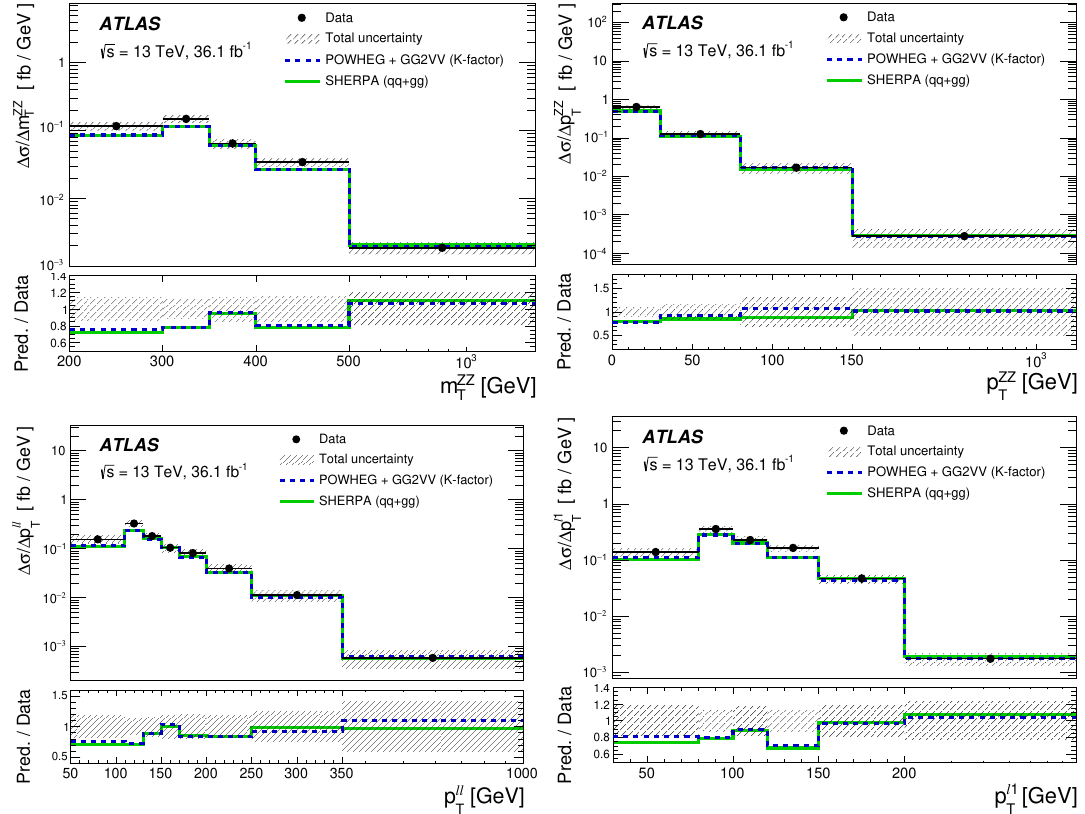
Figure 6 . The measured di(cid:11)erential cross-sections for m ZZ tom left), and p ‘ 1 (bottom right) in the (cid:12)ducial region. The hashed bands in light grey give T the total uncertainty. Also shown are the predictions as obtained from Sherpa (solid line) and Powheg+gg2vv (dashed line) with higher-order K -factors, as described in section 3. The